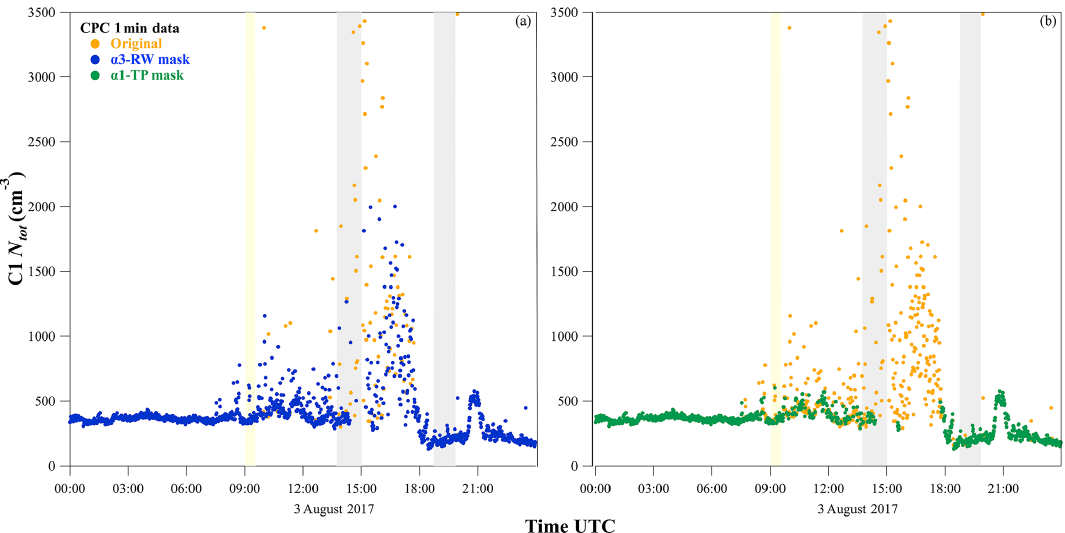
Figure 8. Original (orange points) and masked N tot at C1 using (a) α 3-RW (blue points) and (b) α 1-TP (green points) parameterizations over a 24h period on 3 August 2017. Yellow and gray boxes indicate periods when the AOS cameras at C1 detected trucks and planes, respectively, on the runway. Table 2. R 2 values and percentage of masked N tot data during summer at C1 and S1 using six different combinations of the α parameter and thresholding